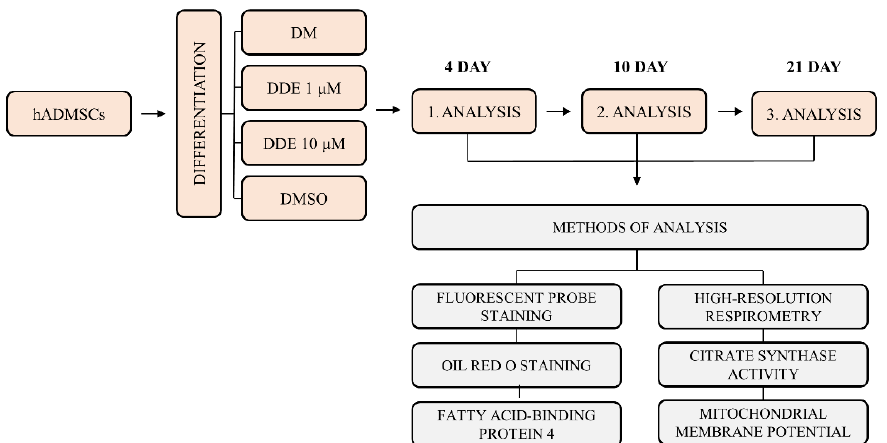
Figure 1. Summary scheme of the experiment.DM: pure differentiation medium; DDE 1 μ M: dif- ferentiation medium with added p,p´-DDE, which was dissolved in dimethyl sulfoxide (DMSO); DDE 10 μ M: differentiation medium with added p,p´-DDE, which was dissolved in DMSO; DMSO: differentiation medium (DM) with DMSO only.